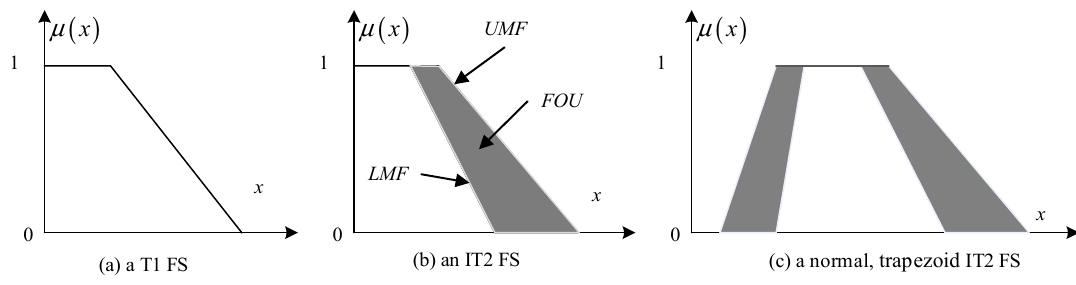
Figure 2. Type-1 fuzzy set, interval type-2 fuzzy set and normal, trapezoid interval type-2 fuzzy number.